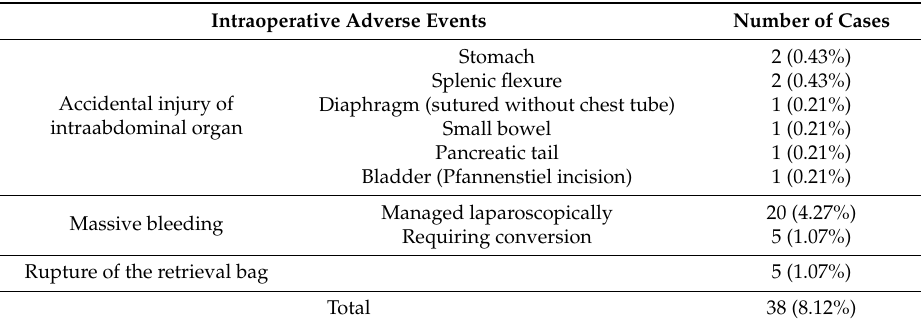
Table 2. Intraoperative adverse events and reasons for